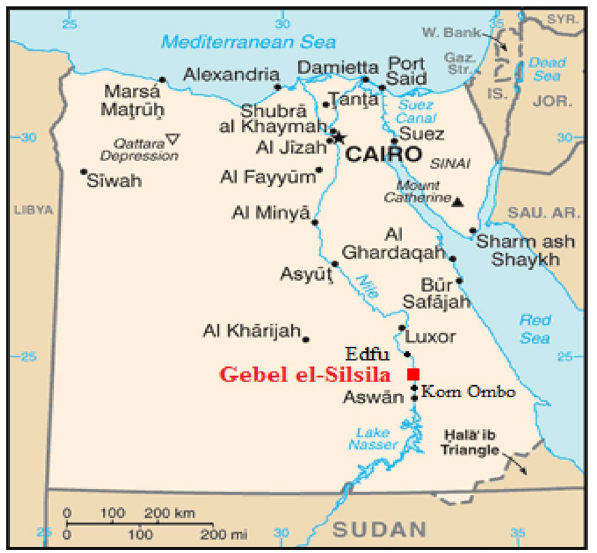
Fig. 1 Location map of Gebel